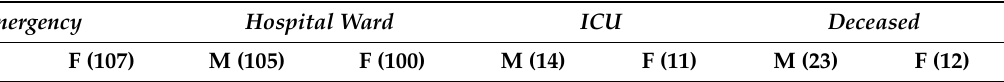
Table 3. Recorded symptoms and comorbidities characterizing the recruited individuals for each